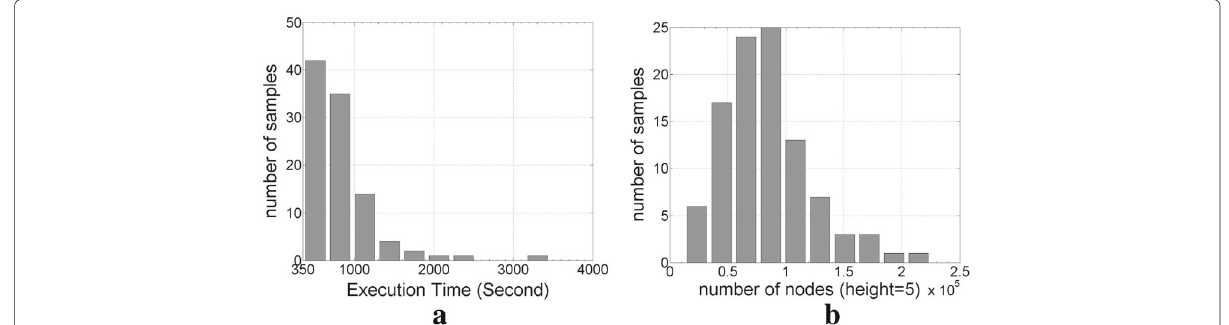
Fig. 3 Histograms of the TSA (based on the pick-3 algorithm) to find α 5 on 100 randomly chosen 20 × 40 Gaussian sensing matrices for each method. a Execution time. b Number of nodes in height 5